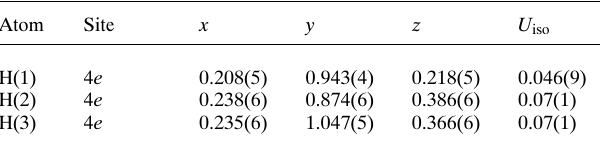
Table 2. Atomic coordinates and displacement parameters (in Å 2 )